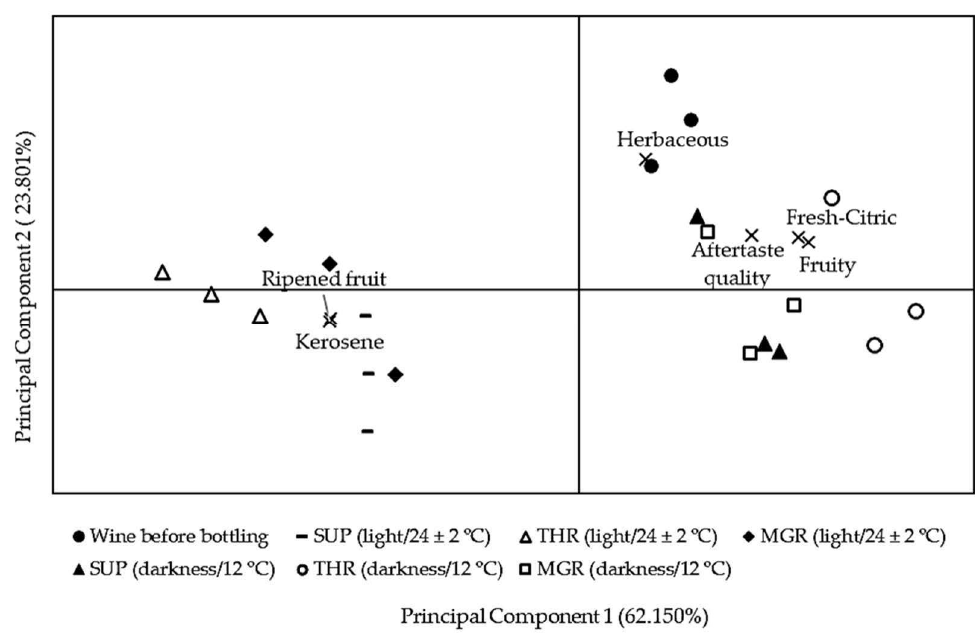
Figure 3. Distribution in the space of wines before bottling and those storage for one year under the different conditions tested, joint with their sensorial attributes (x). SUP: super quality natural corks; THR: third quality natural corks; MGR: microgranulated corks.